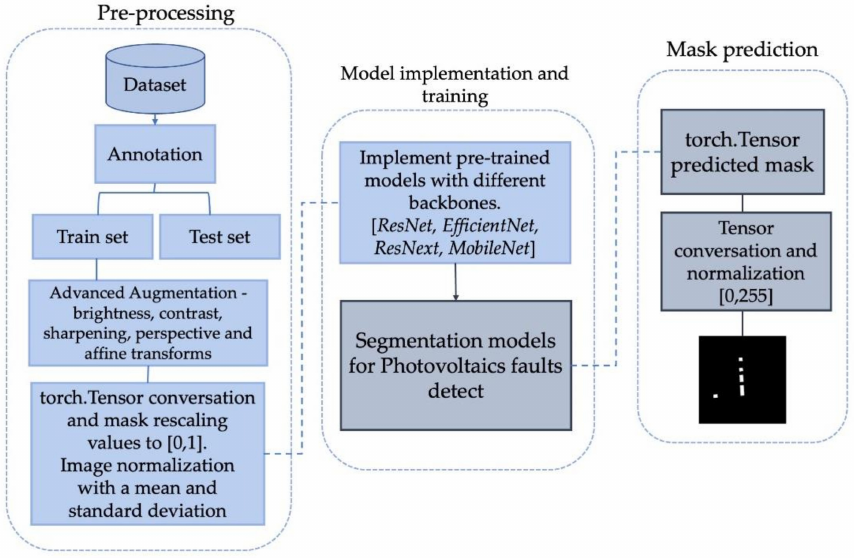
Figure 6. A framework of Photovoltaics fault detection using deep